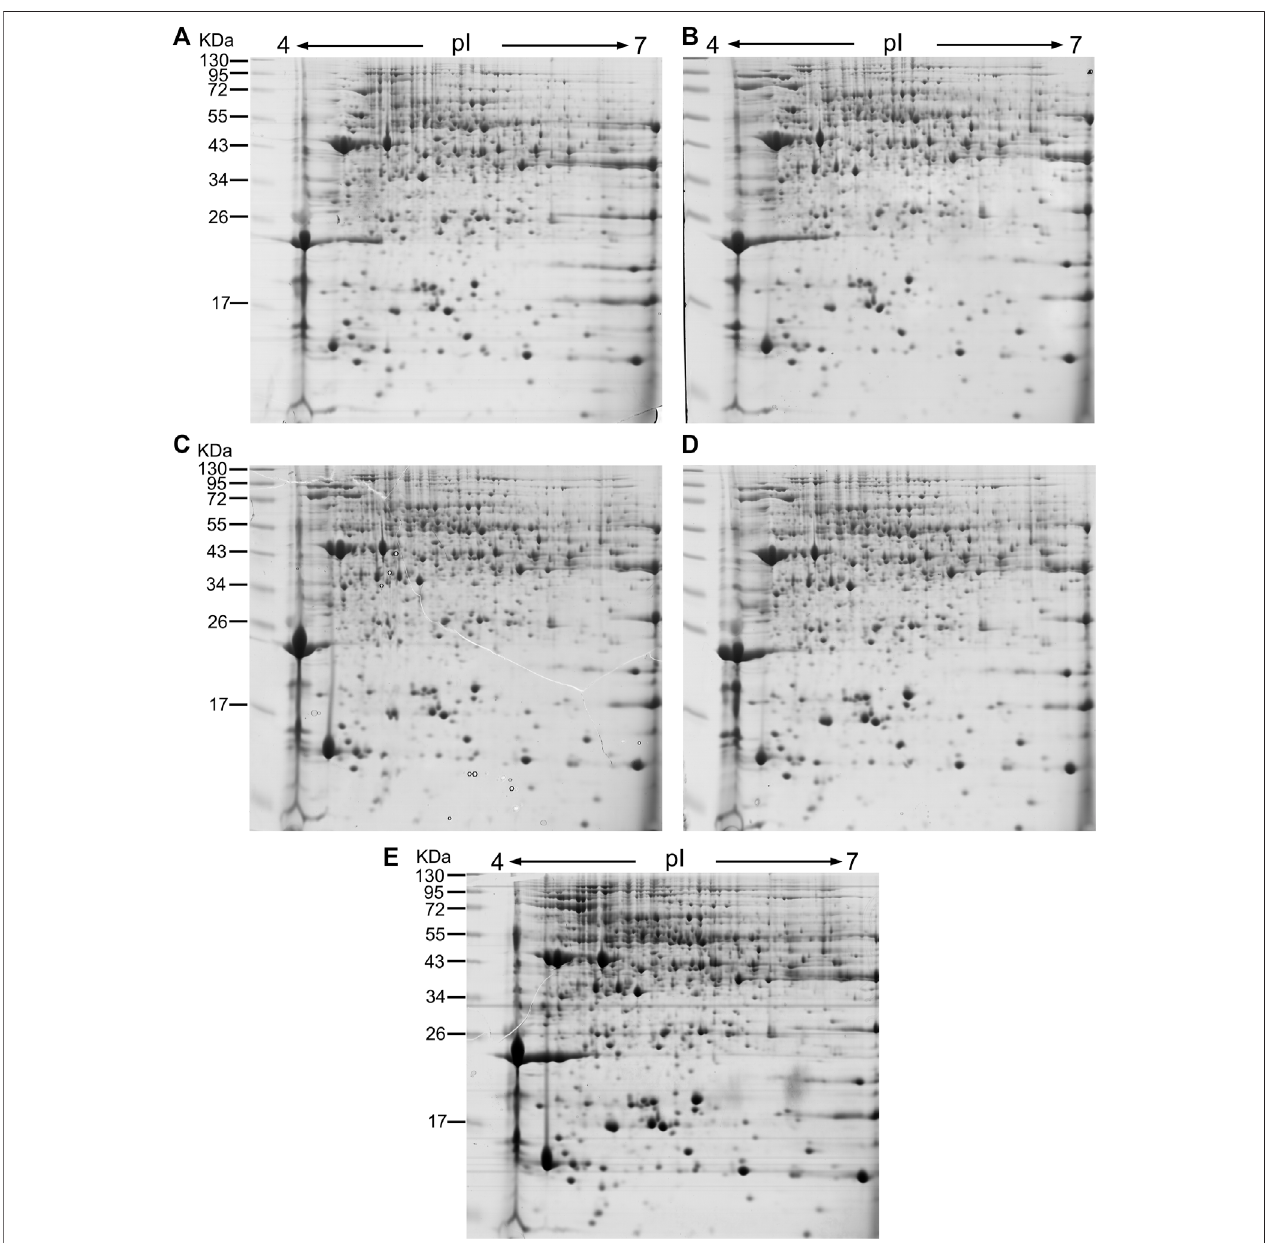
FIGURE 2 | 2-DE images of latex C-serum proteins from retapped Hevea trees after a four-month resting period. IGP strips of pH4-7 were used in 2-DE, and the fresh latex C-serum samples were analyzed for the fi rst fi ve tappings [ (A) : fi rst; (B) : second; (C) : third; (D) : fourth; (E) : fi fth]. kDa: Molecular weight of protein. pI: Protein isoelectric